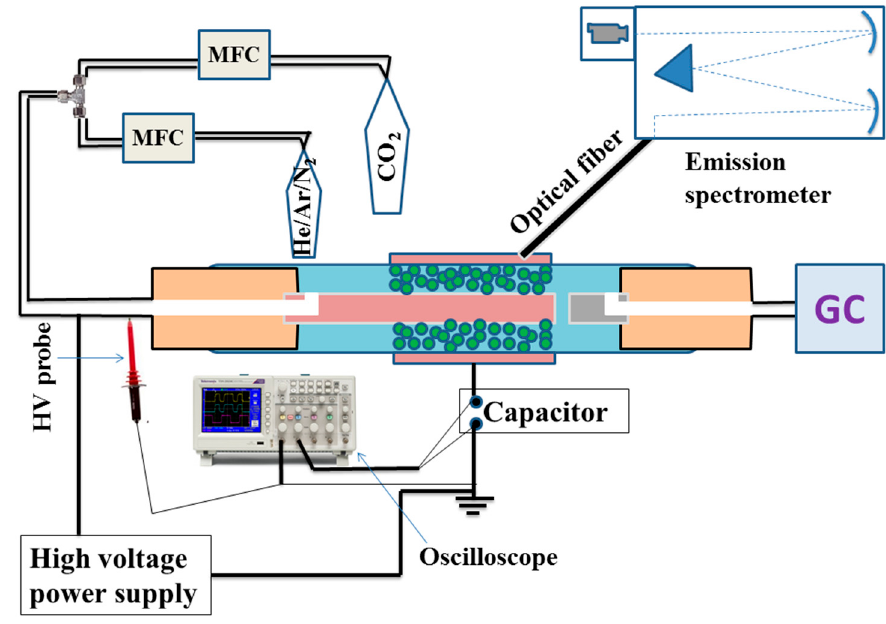
Figure 10. Simplified diagram of experimental set up.